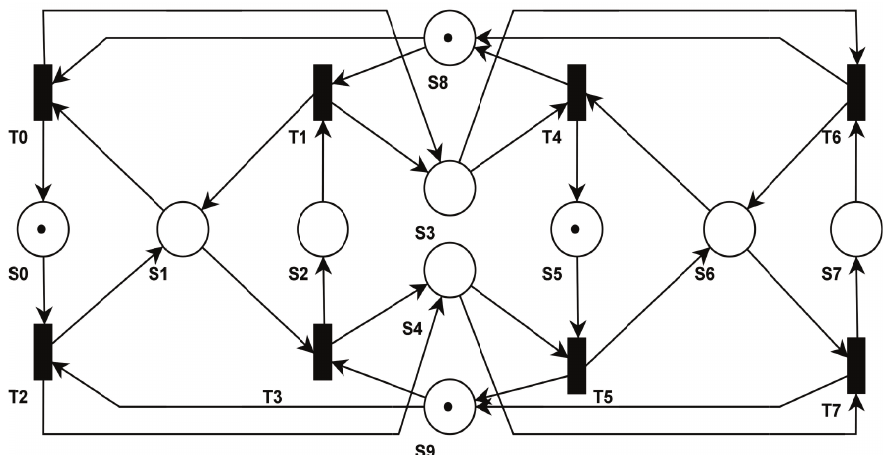
Figure 4. Improved Petri net of